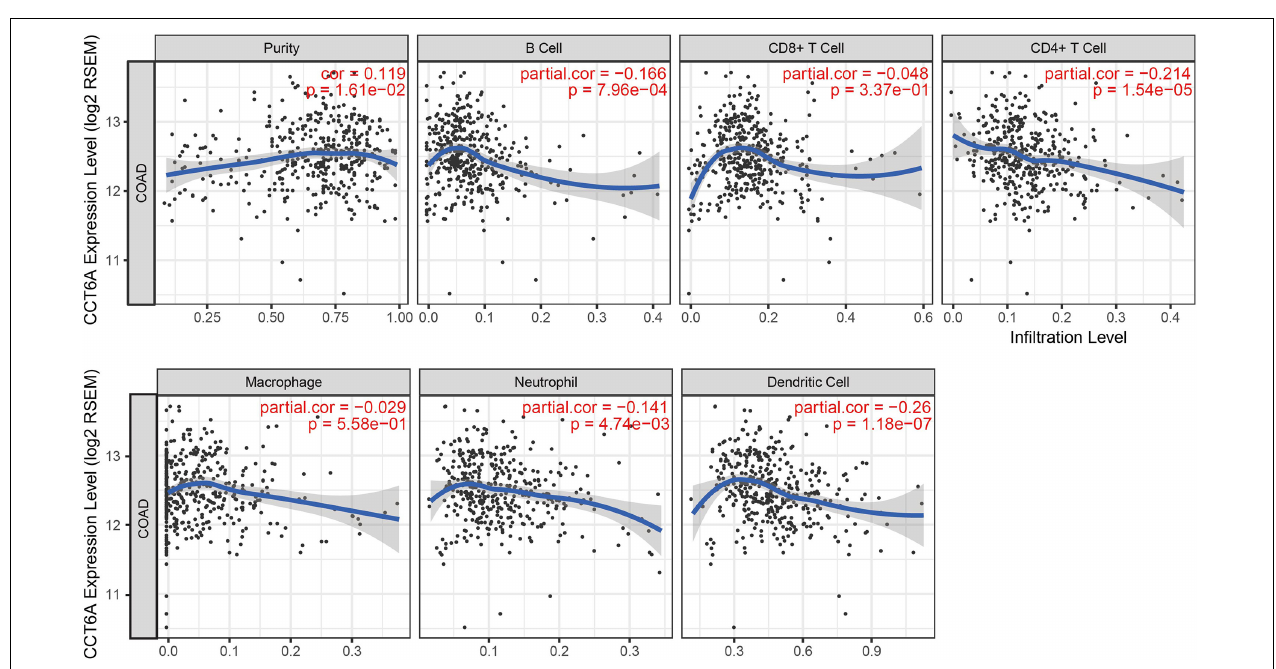
FIGURE 7 | Correlation of CCT6A expression with immune infiltration level in COAD (colon adenocarcinoma).